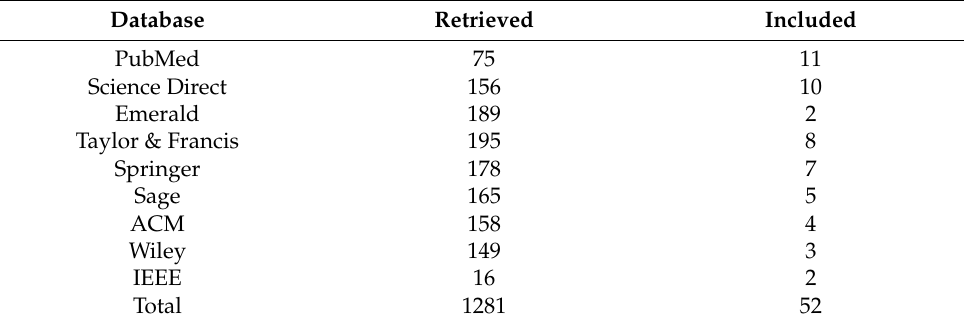
Table 2. The number of articles that were filtered based on search